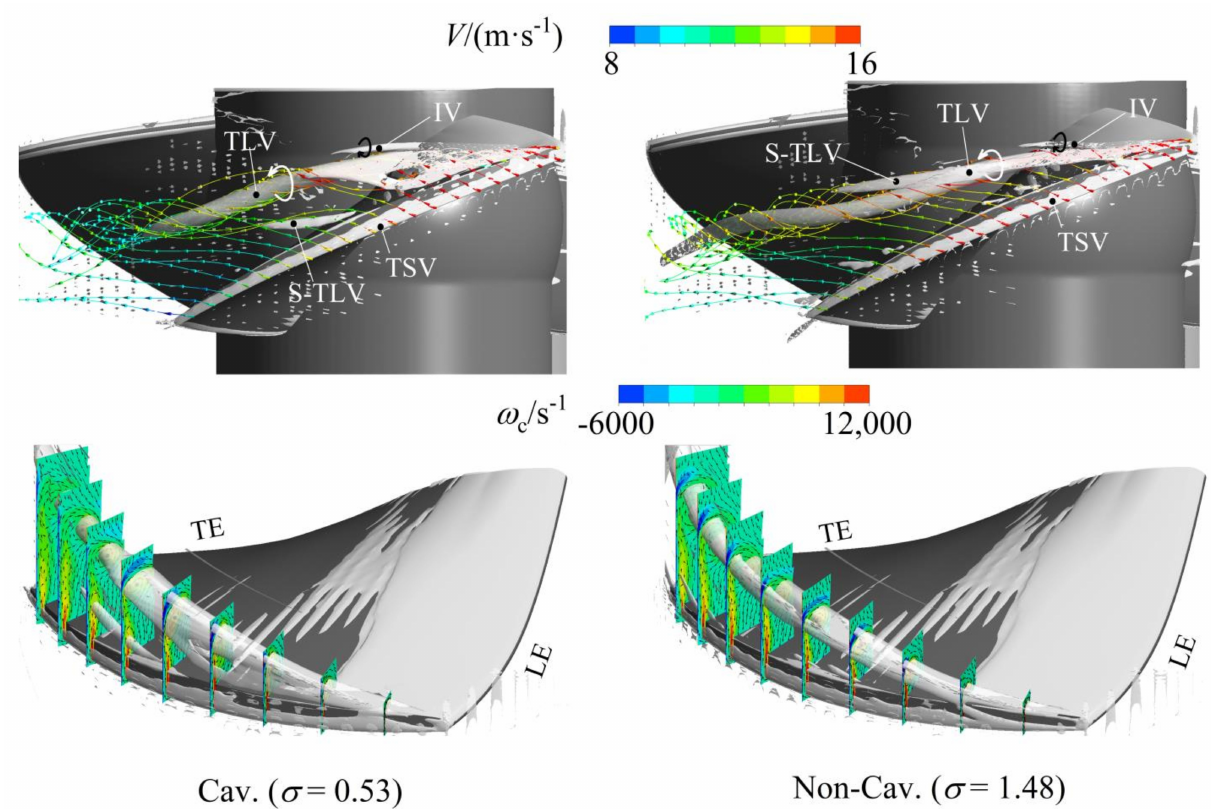
Figure 8. Three − dimensional leakage streamlines with velocity and Q —criterion isosurface (value of 3 × 10 6 s − 2 ) for the axial—flow